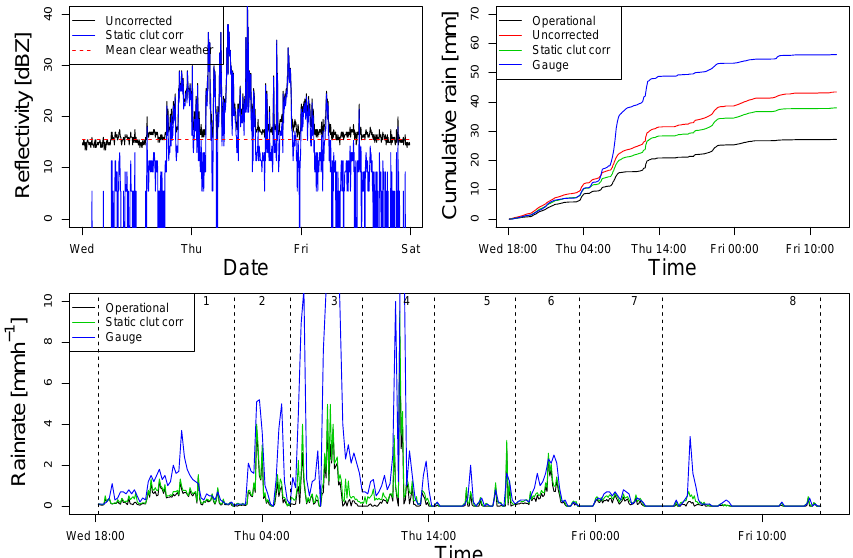
Figure 6. Top-left panel: reflectivity of the studied range bin between 1 and 2km from the radar of the uncorrected reflectivity (black) and the static-clutter-corrected reflectivity (blue). Here the red dashed line is the average reflectivity when there is no rain. Top right panel: the cumulative rain sums for the rain gauge (blue) and the Doppler clutter-corrected reflectivity (black), together with the uncorrected (red) and the static-clutter-corrected reflectivity (green) using the Marshall–Palmer Z – R relation with 1dB added to compensate for calibration errors. Bottom panel: time series of the rain gauge, Doppler clutter-corrected and the static-clutter-corrected rain